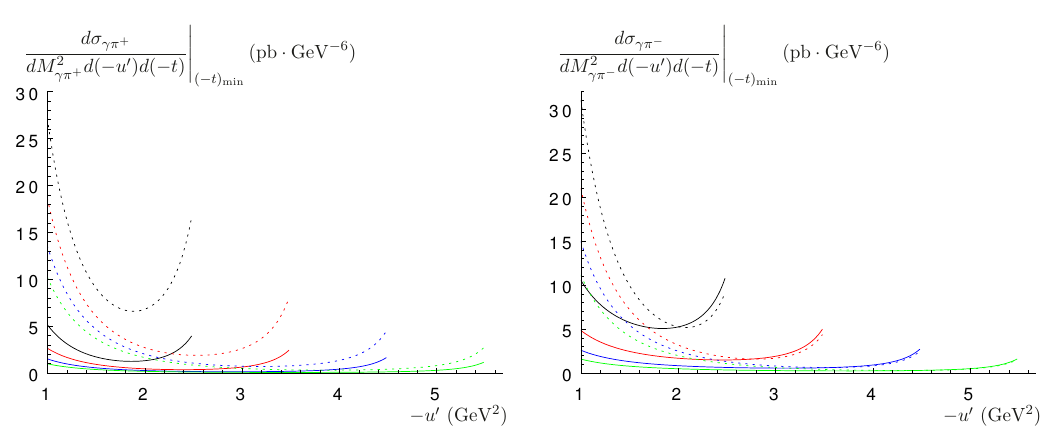
Figure 4 . Left: differential cross section for the production of a photon and a π + meson on a proton target. Right: differential cross section for the production of a photon and a π − meson on a neutron target. Both cross-sections are at M 2 = 4 GeV 2 , S γ N = 20 GeV 2 , t = ( t ) min as a γπ − − function of u ′ . In black the contributions of both vector and axial GPD, in blue the contribution − of the vector GPD, and in green the contribution of the axial GPD. Solid: “valence” model, dotted: “standard” model. There is no interference between the vector and axial amplitudes.